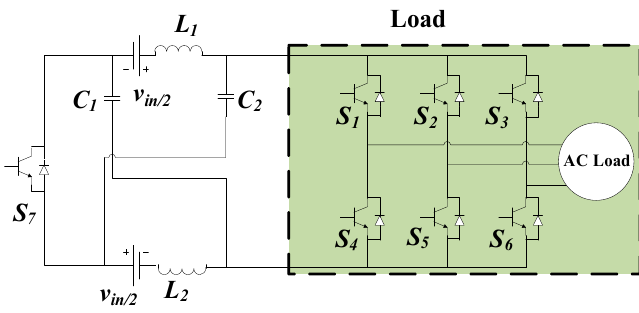
Figure 3. Bidirectional embedded Z-source inverter topology.